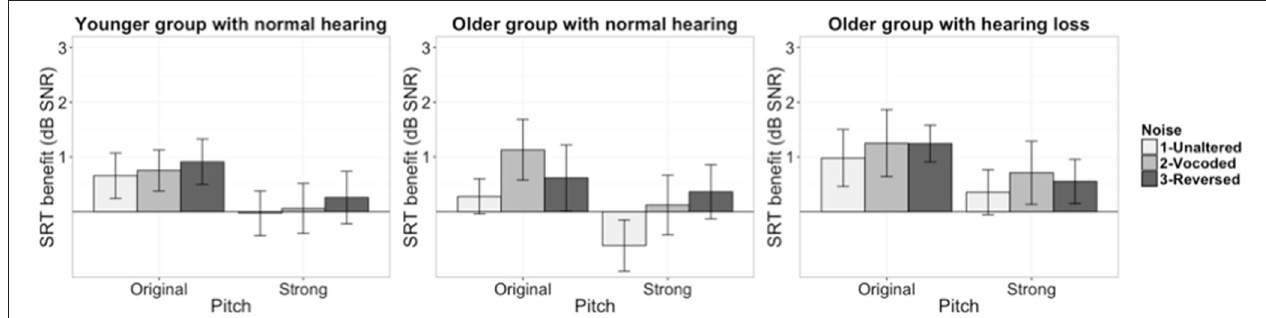
FIGURE 2 | Dynamic benefit scores of all listener groups (left panel: younger group with normal hearing, middle panel: older group with near-normal hearing, right panel: older group with hearing loss. Error bars present ± 1 standard error).